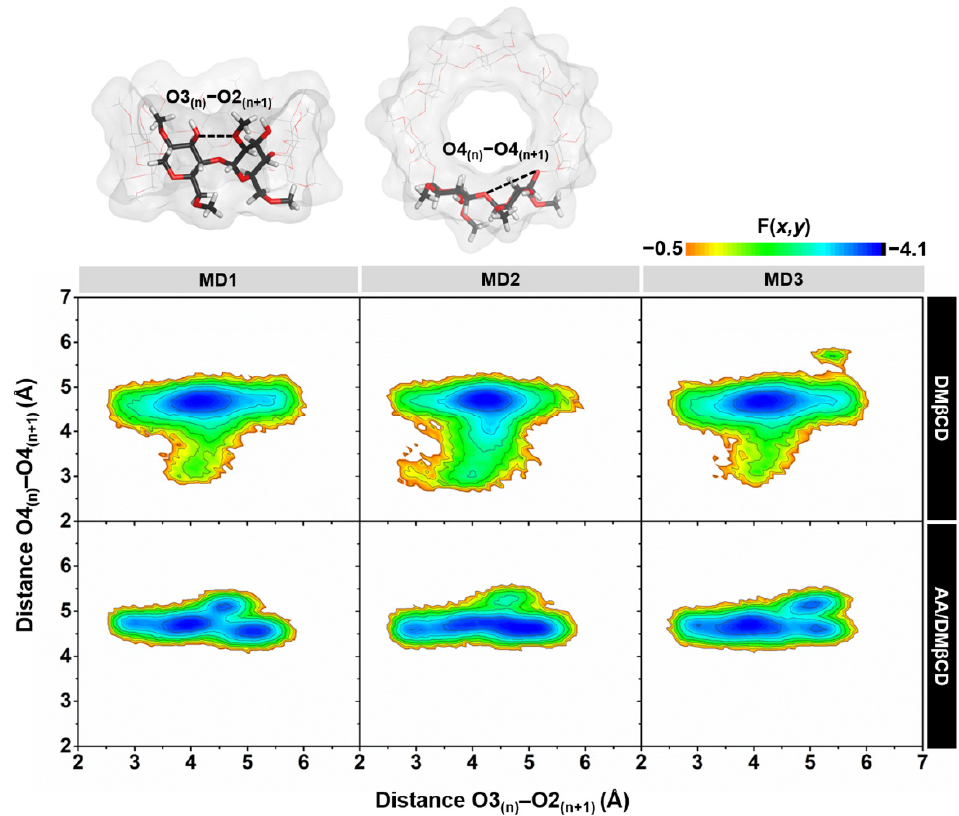
Figure 8. 2D free energy (F( x , y )) landscape of the intramolecular hydrogen bond distances, O3 (n) – O2 (n+1) , against the adjacent glycosidic oxygen distances, O4 (n) –O4 (n+1) , of the DM β CD ( top ) and AA/DM β CD complex ( bottom ) for three independent simulations (MD1–3).